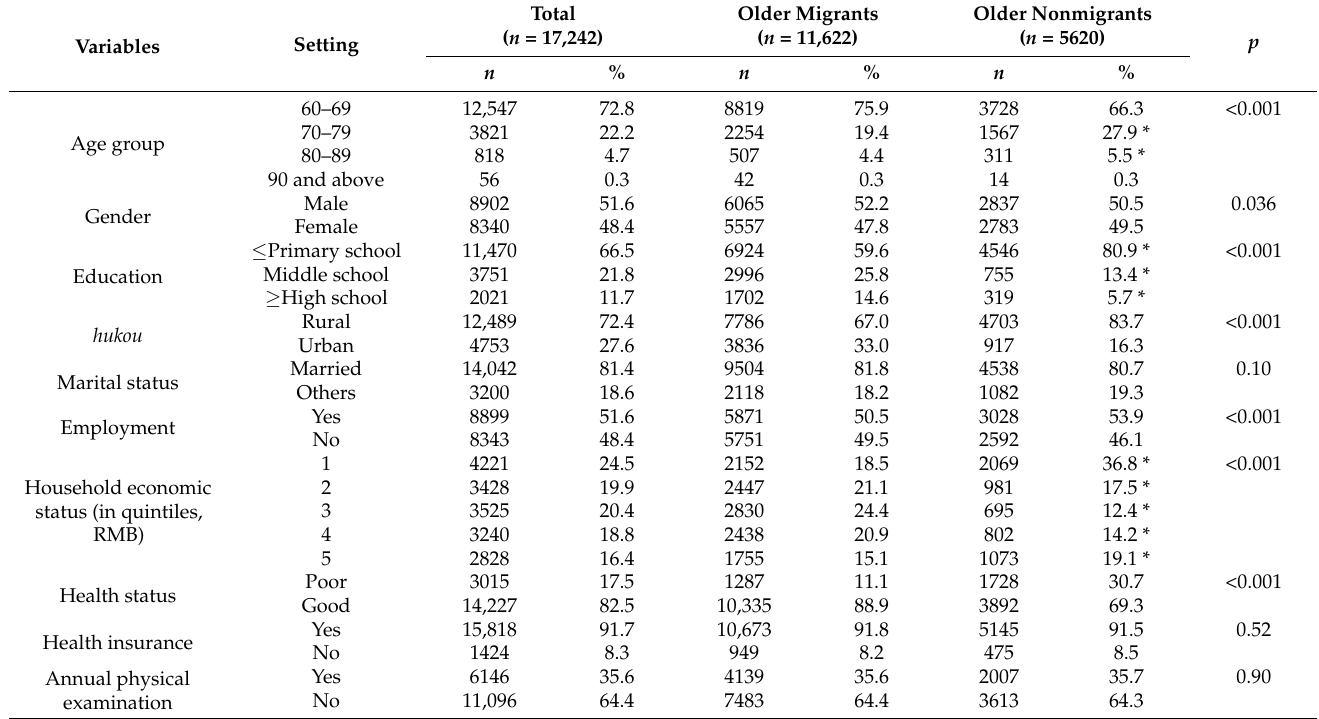
Table 1. Characteristics of older migrants and older